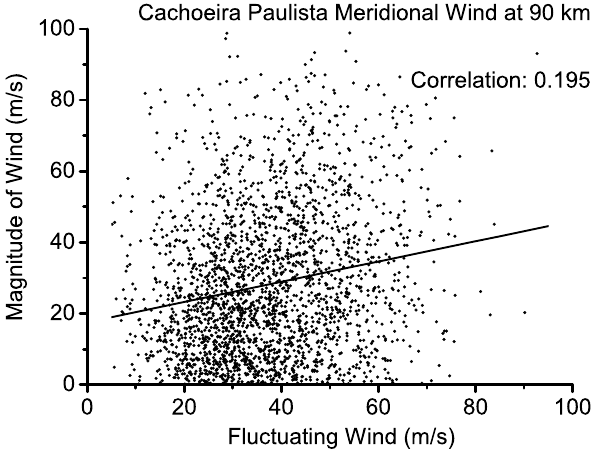
Fig. 7. Mass plot of 3h samples of the 90-km background wind magnitude plotted against fluctuating wind magnitude measured at Cachoeira Paulista for the year of